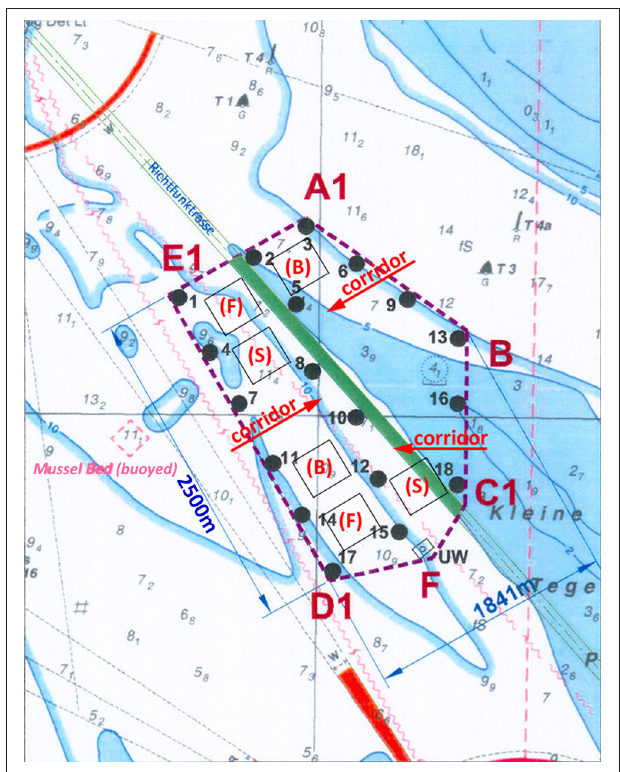
FIGURE 7 | Map of the offshore wind farm Nordergründe ∼ 17 nautical miles off the coast from the city of Bremerhaven (North Germany). This figure shows a bird’s eye view displaying 18 offshore wind turbines (numbers without brackets) and six single aquaculture plots (numbers with brackets) designated by the wind farm company. All six designated plots were declared for IMTA, including fish cultivation (F), seaweed cultivation (S), and bivalve (mussel) cultivation (B). Black arrows indicated corridors for vessels to enter the wind farm area to service turbines, which are located in the center of the wind farm area (Image with permission of the publisher modified after Buck et al.,